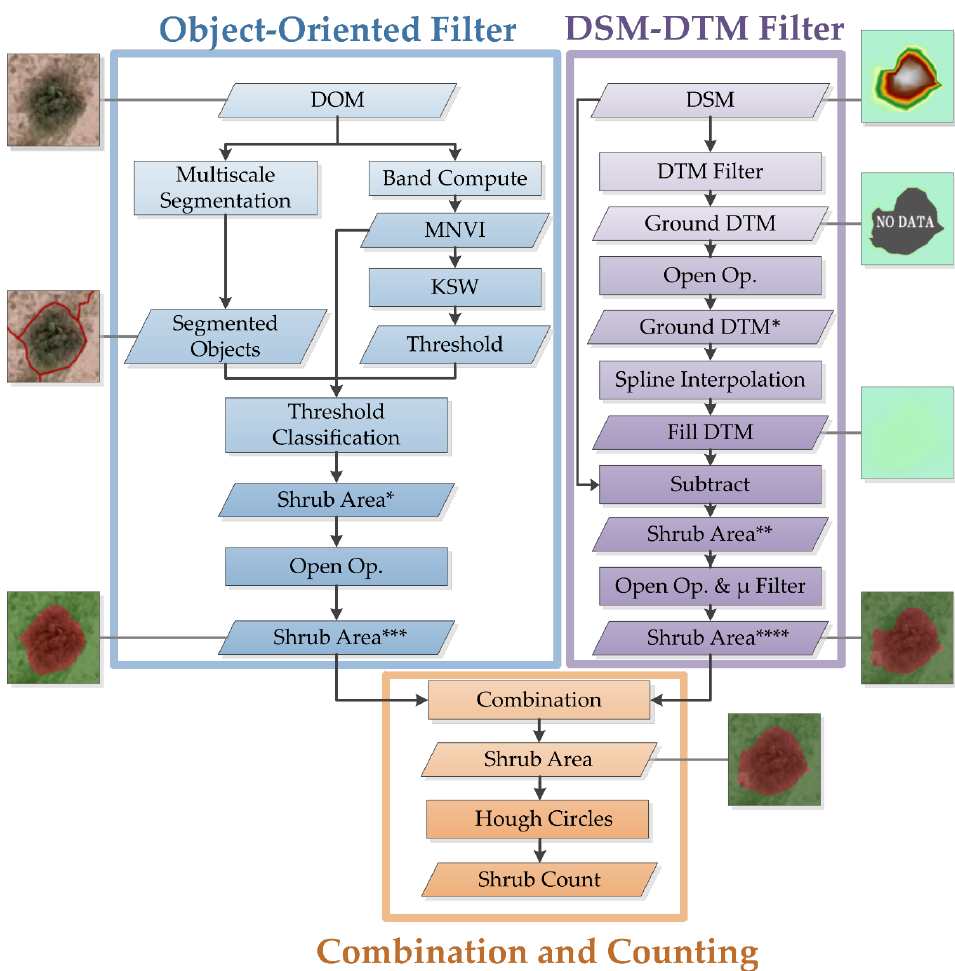
Figure 2. Flow chart of the combining object-oriented filter and digital surface model (DSM) - digital terrain model (DTM) algorithm (CODA) for shrub identification (where Open Op. refers to open operation).